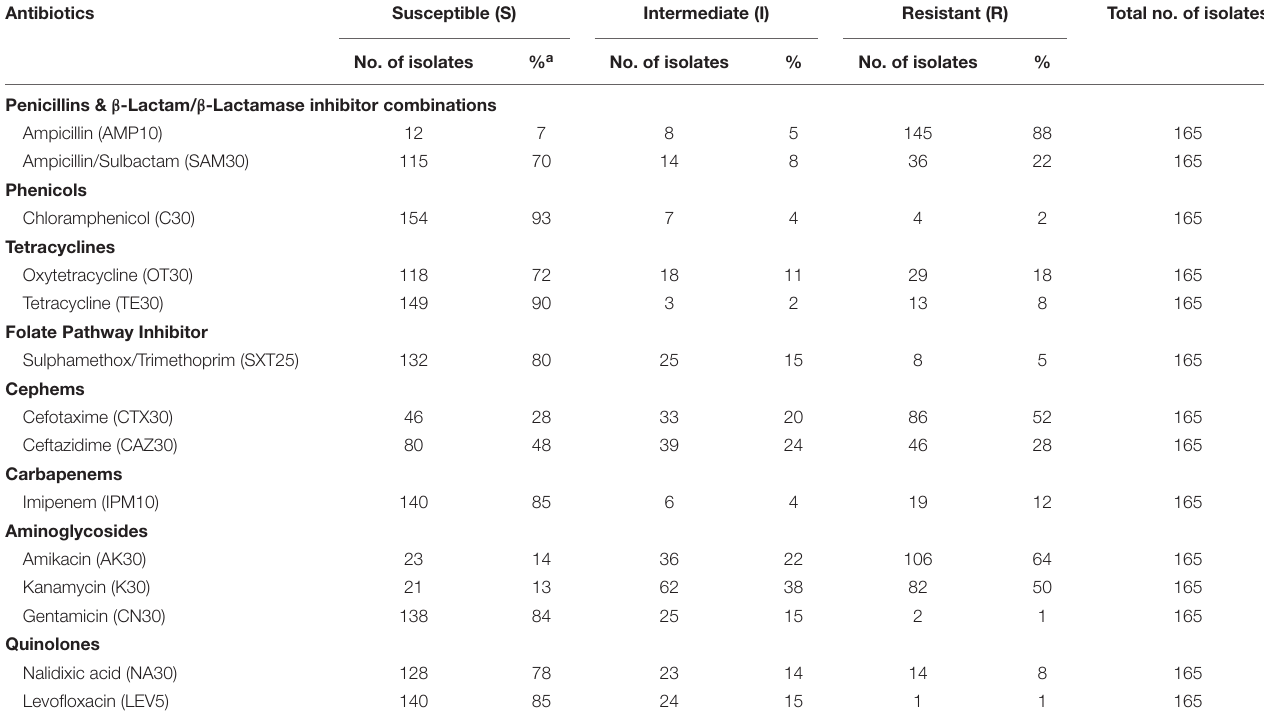
TABLE 2 | Percentage of antibiotic susceptible, intermediate, and resistant of V. parahaemolyticus isolated from various fish samples. Antibiotics Susceptible (S) Intermediate (I) Resistant (R) Total no. of